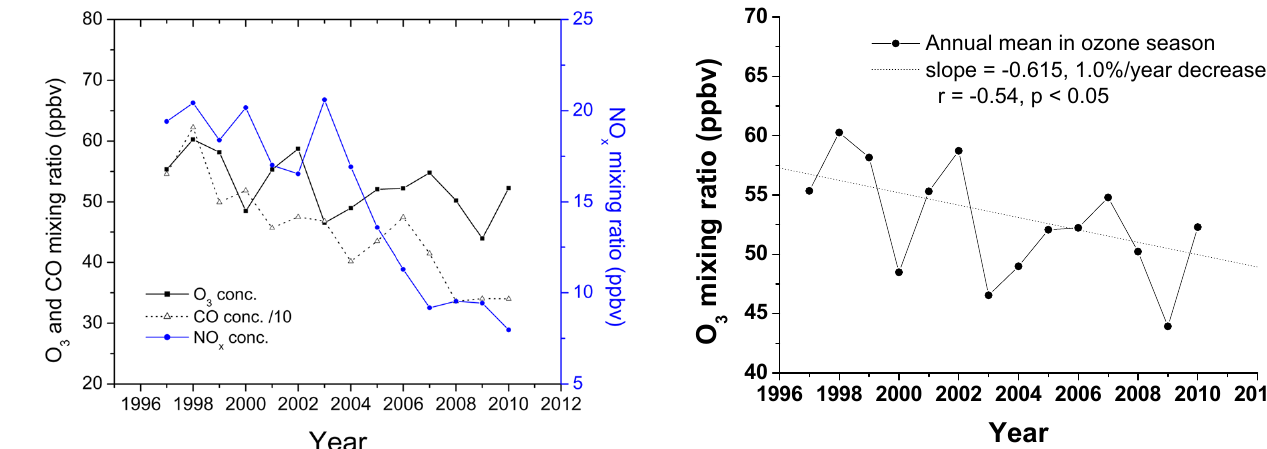
Fig. 3. Long-term trends of ground-level O 3 , CO, and NO x ob- served in the Baltimore/Washington area in EPA AQS sites (sites shown in Fig. S4 of the Supplement). CO mixing ratios have been scaled by 10 for clarity. To investigate the ozone chemistry, mea- surements in the afternoon (12:00–18:00 LT) during the ozone sea- sons were used to calculate annual means.